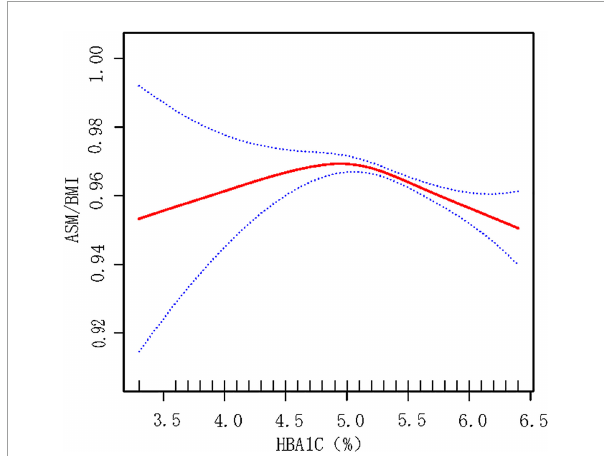
FIGURE3 Smooth fitting curve reflecting the relationship between HbA1c and ASM BMI in male non-T2DM population. Adjusted for age, race, BMI, HTN, alcohol use, cigarette use, vigorous activity status, education level, TC, TG, SUA, SCr, ALT, TBP, taking medicine for lowing cholesterol, and total energy intake. HbA1c below 5.2% may indicate malnutrition, which is associated with less muscular mass. HbA1c over 5.2% may indicate over energy storage and abnormal glycemia metabolism. ASM, appendicular skeletal muscle mass. ASM BMI = ASM/BMI.